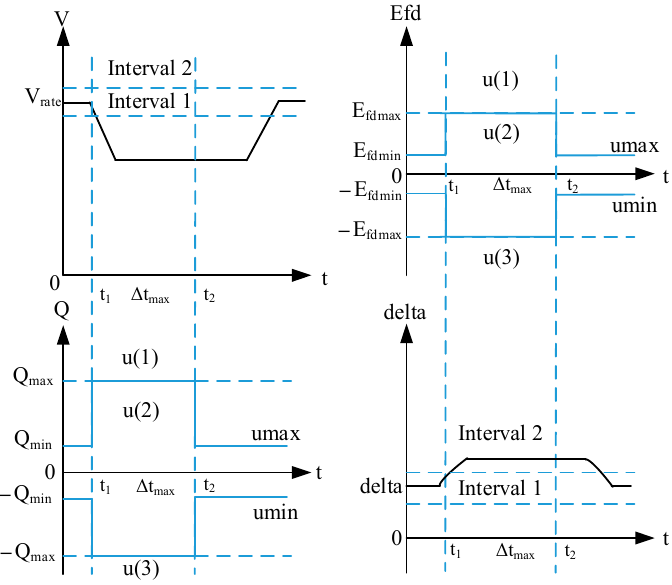
Figure 3. Mode selection of the amplitude limiter.